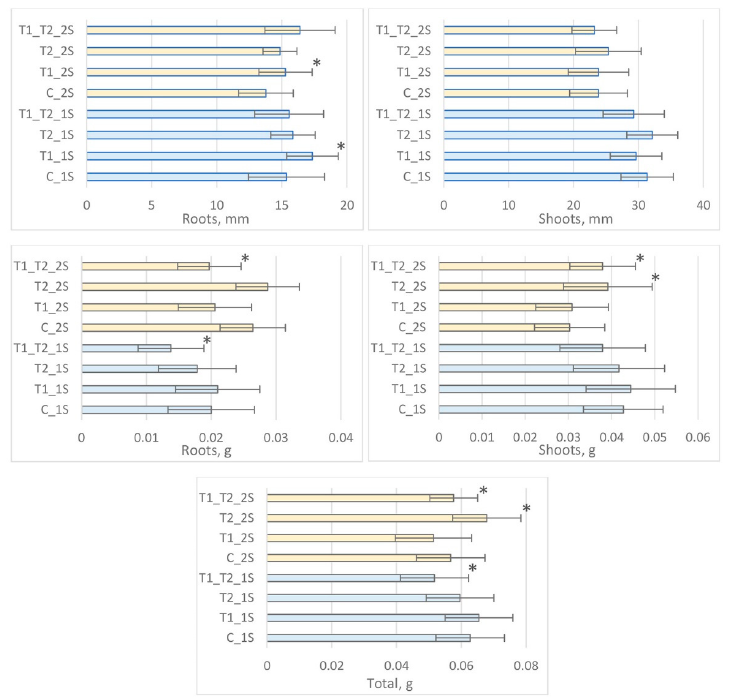
Figure 4. Effects of inoculation with Trichoderma spp. on vegetative plant growth. C_1S—grassland non-inoculated, T1_1S—grassland inoculated with T. tomentosum , T2_1S—grassland inoculated with T. ghanense , T1_T2_1S—grassland inoculated with the complex T. tomentosum + T. ghanense , C_2S—arable soil non-inoculated, T1_2S—arable soil inoculated with T. tomentosum, T2_2S—arable soil inoculated with T. ghanense , T1_T2_2S—arable soil inoculated with the complex T. tomentosum + T. ghanense . * above the bars indicate significant differences. The greatest beneficial effect of T. tomentosum on rye was noticed in grassland 1S (Figure 4). A statistically significant difference was established for the length of the roots of rye in grassland with the inoculation of T. tomentosum ( p = 0.005). The total weight of the rye seedling was 3.2% larger in grassland than in non-inoculated soil (control), though a significant difference was not observed ( p = 0.321). Furthermore, while the weight of the shoot and root of the rye seedlings was larger compared to the control, unfortunately these differences were not significant ( p = 0.345 and p = 0.331, respectively).